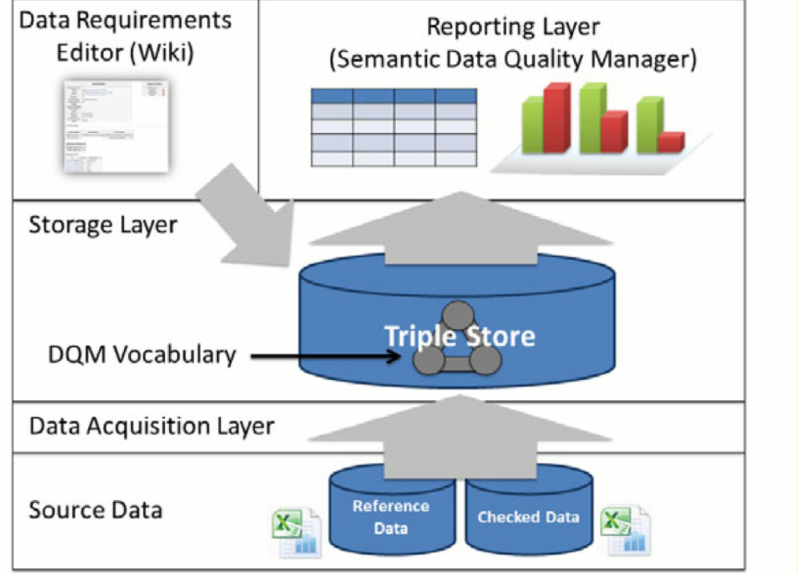
Figure 1: Christian Fürber’s Semantic Data Management Framework in C.Fürber, Data Quality Management with Semantic Technologies, Wiesbaden: Springer, 2016, p.87. Using Fürber as a reference, the analytics team replicated the semantic data modelling framework to develop a semantic model using SQL Server. The objective was to build semantic search capabilities within the SQL server which allows the user to query the meaning of the document due to automatic tag extraction, content discovery, and navigation across similar